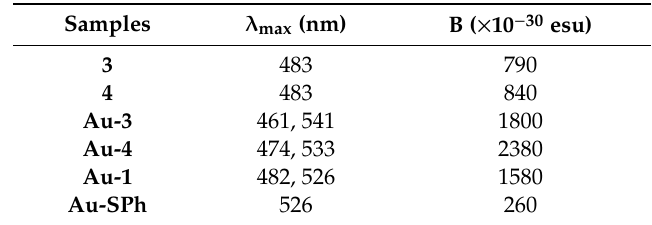
Table 1. Maximum absorption wavelength λ max and hyperpolarizabilities λ max per dye unit for dyes 3 and 4 , dye–nanoparticle associations Au-3 and Au-4 , nonfunctionalized gold nanoparticles Au-SPh , and Au-1 mixture without link between dye 1 and Au-SPh . Hyperpolarizability measurements were performed at 1.64 µ